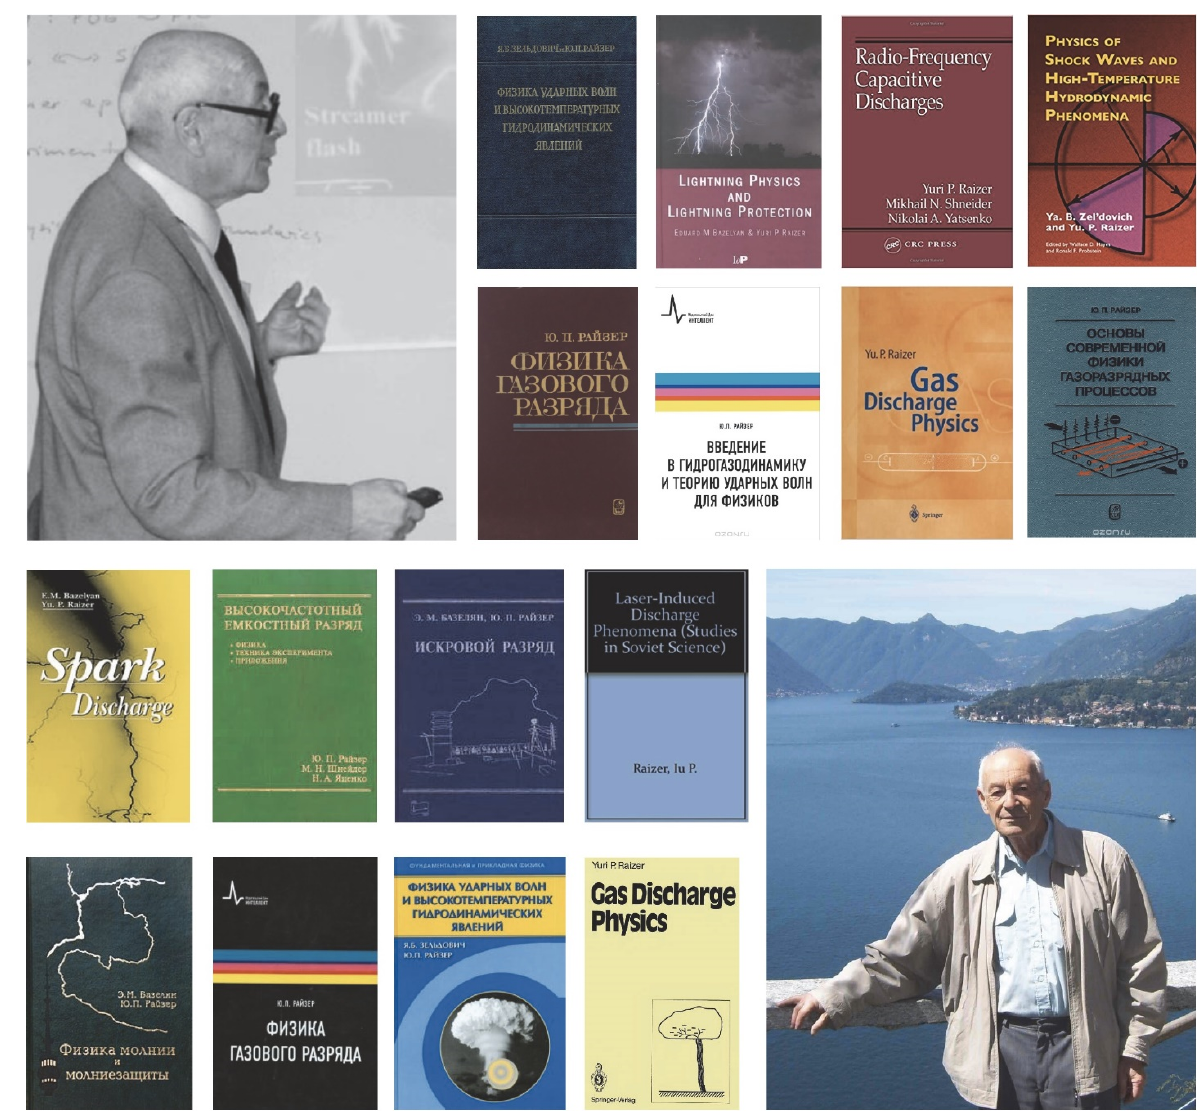
Figure 1. Prof. Yuri Raizer and his books.